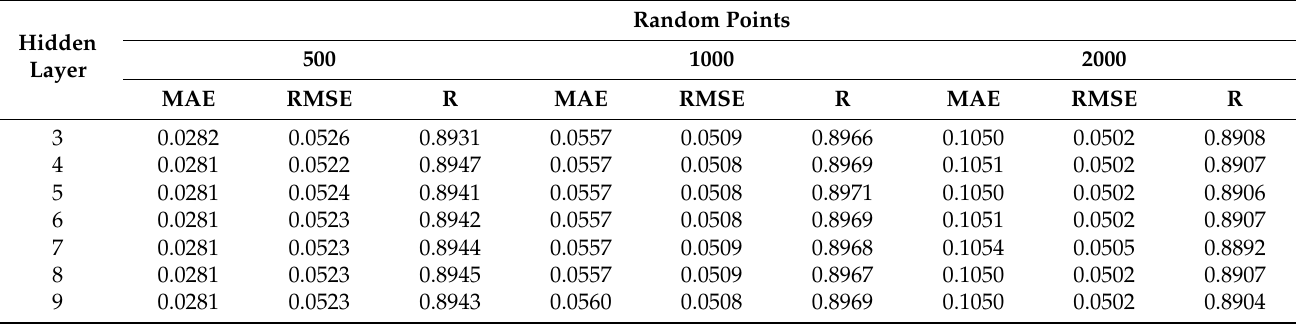
Table 6. Hidden layers and random points of reconstructed NDVI model based on